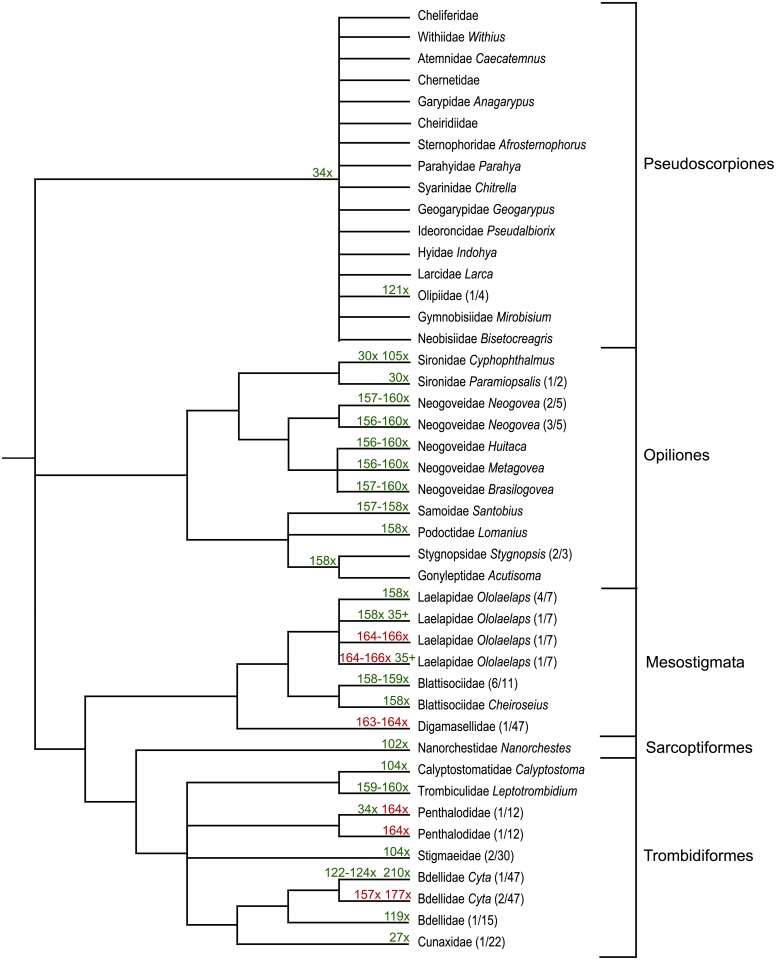
Phylogenetic relationships of taxa with indels in the COI barcode region with ‘X’ designating a deletion and ‘+’ an insertion.The numbers indicate the position of each indel in the alignment with green for those in loop regions, and red for those in others.